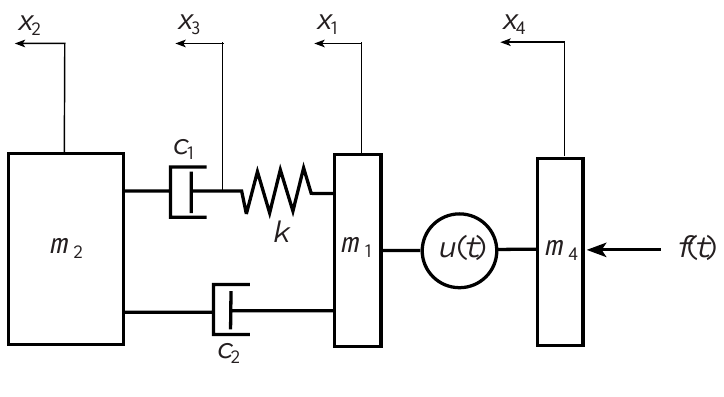
Fig. 2. Model of the head with